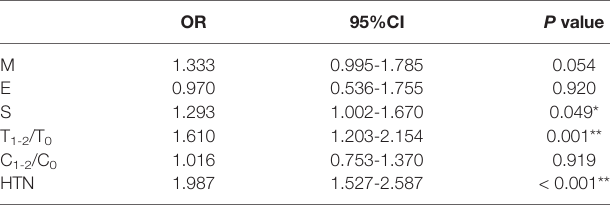
TABLE 3 | Logistics regression models for the relationship between TG/HDL-C and kidney pathologic lesion. OR